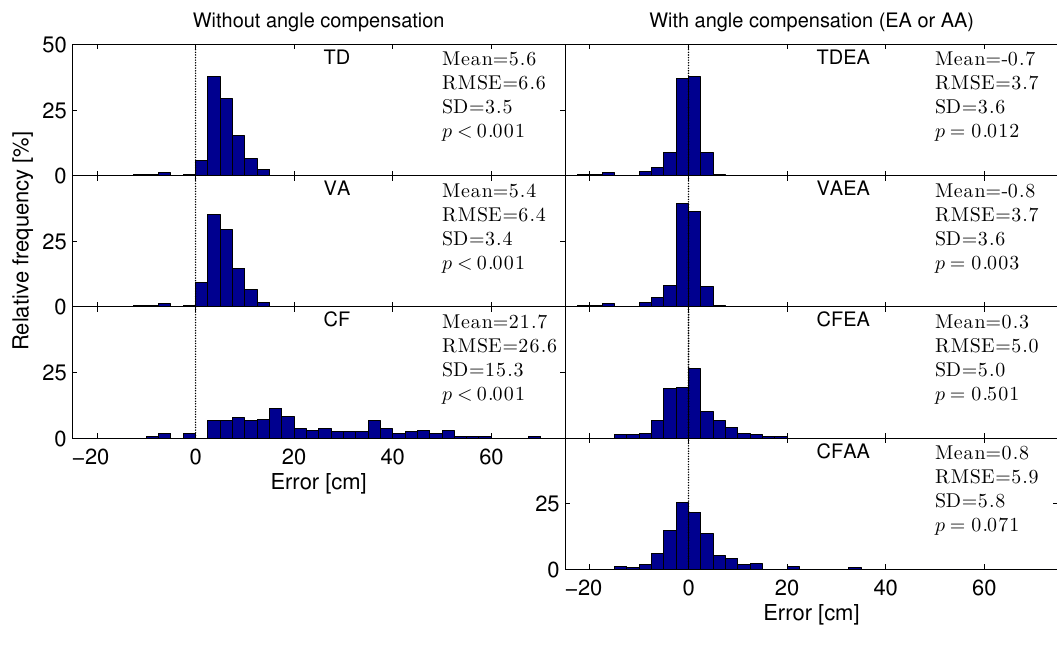
Figure 6. Distribution of diameter estimation errors (positive error values = overestimation, negative values = underestimation) for the 7 algorithms, when applying the MD multiple scans method. p -values indicate the probability for obtaining the observed mean values when the true value is zero (1-sample T-test). Thus, p < 0 . 05 indicate systematic bias (over or under estimation). Zero error is indicated by dotted vertical line. N = 170, besides for CF for which N =